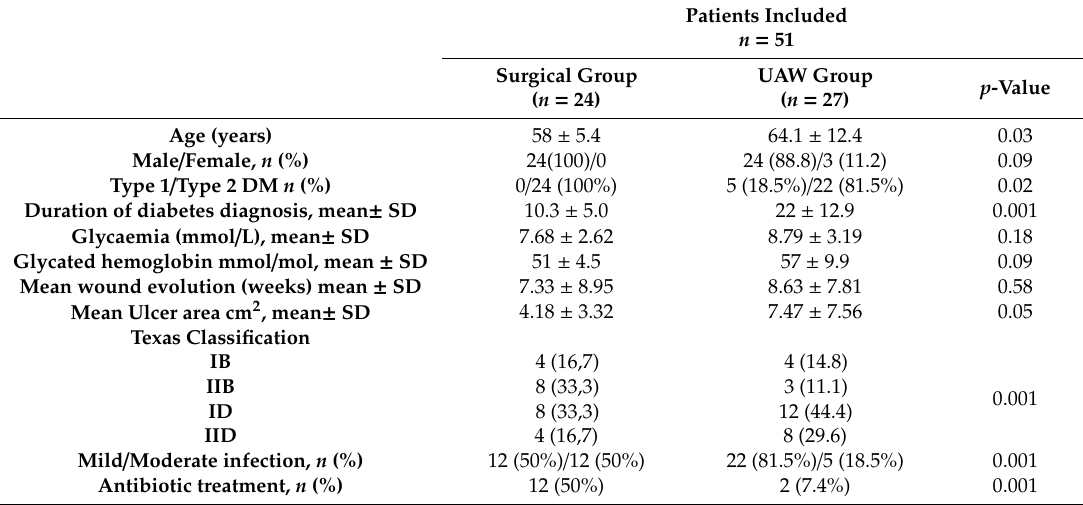
Table 1. Clinical and demographic characteristics of the study population.